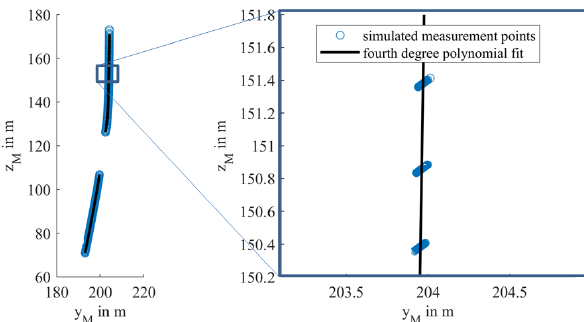
Figure 6. Simulated points on blades for 263 scans with noise added to each simulated measuring point (blue circles) for the case γ = 0 ◦ . A fourth-degree polynomial is fitted through the simulated points (black